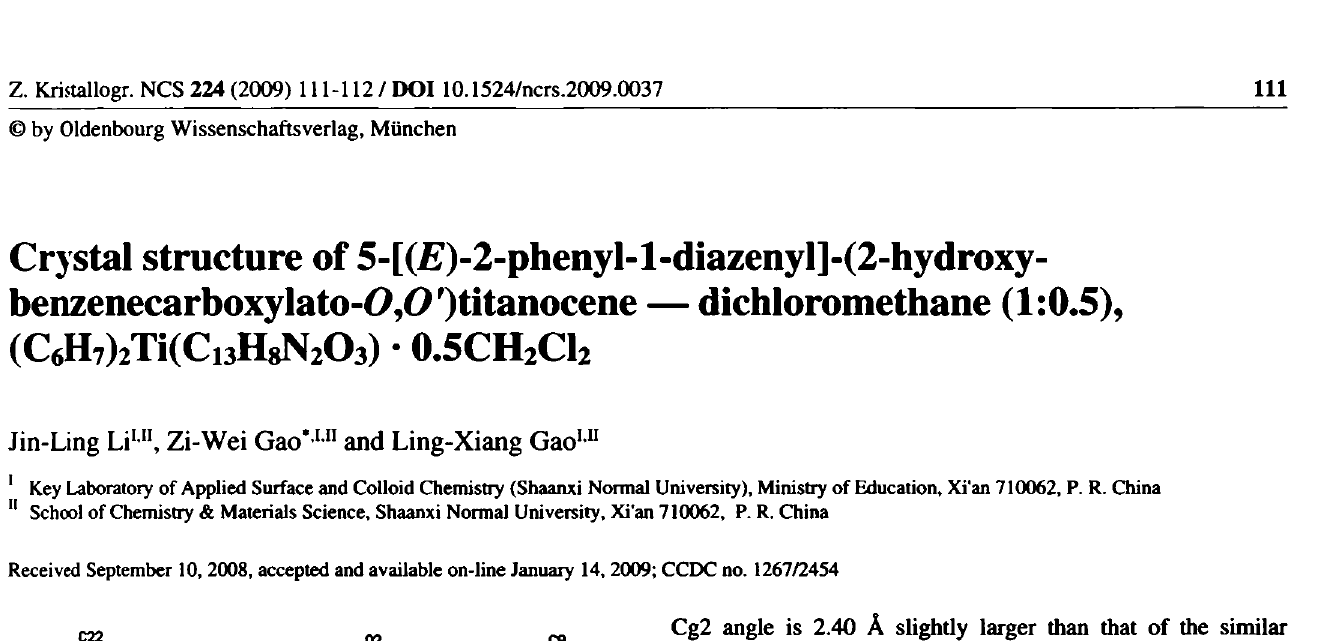
Table 1. Data collection and handling.